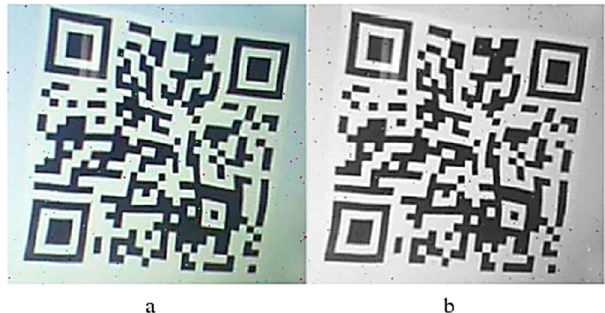
Figure 8: The comparison of image ( a ) before grayscale conversion and ( b ) after the grayscale result.